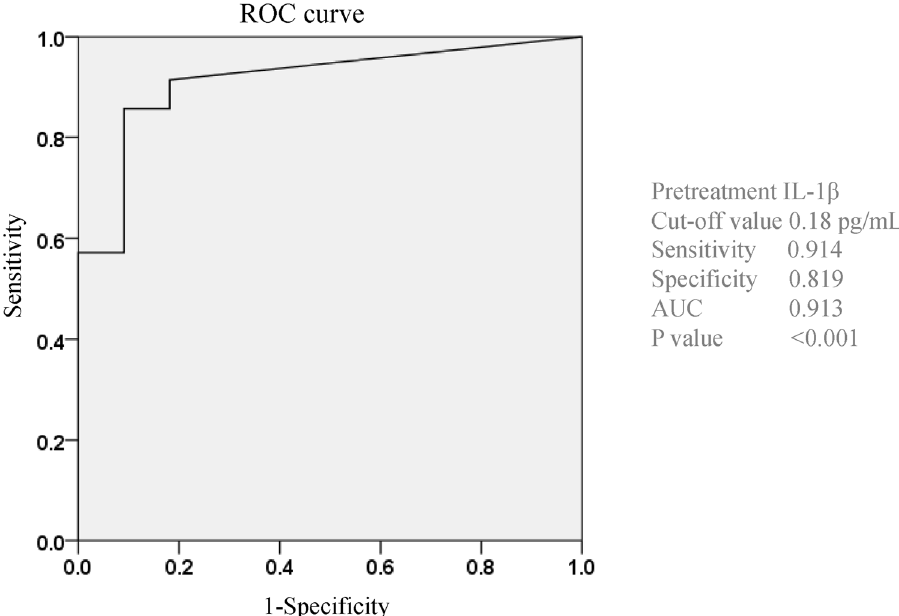
Figure 3. Cutoff value of baseline IL-1β level for predicting HBV reactivation in HCV-infected patients with previous HBV infection during DAA therapy. Receiver operating characteristic (ROC) curve analysis for baseline IL-β levels in HCV-infected patients with previous HBV infection. The cutoff baseline IL-1β level for predicting HBV reactivation during DAA therapy was set at 0.18 pg/mL (area under the ROC curve, 0.913; sensitivity, 0.914; specificity, 0.819). HCV hepatitis C virus, HBV hepatitis B virus, DAA direct-acting antiviral, IL